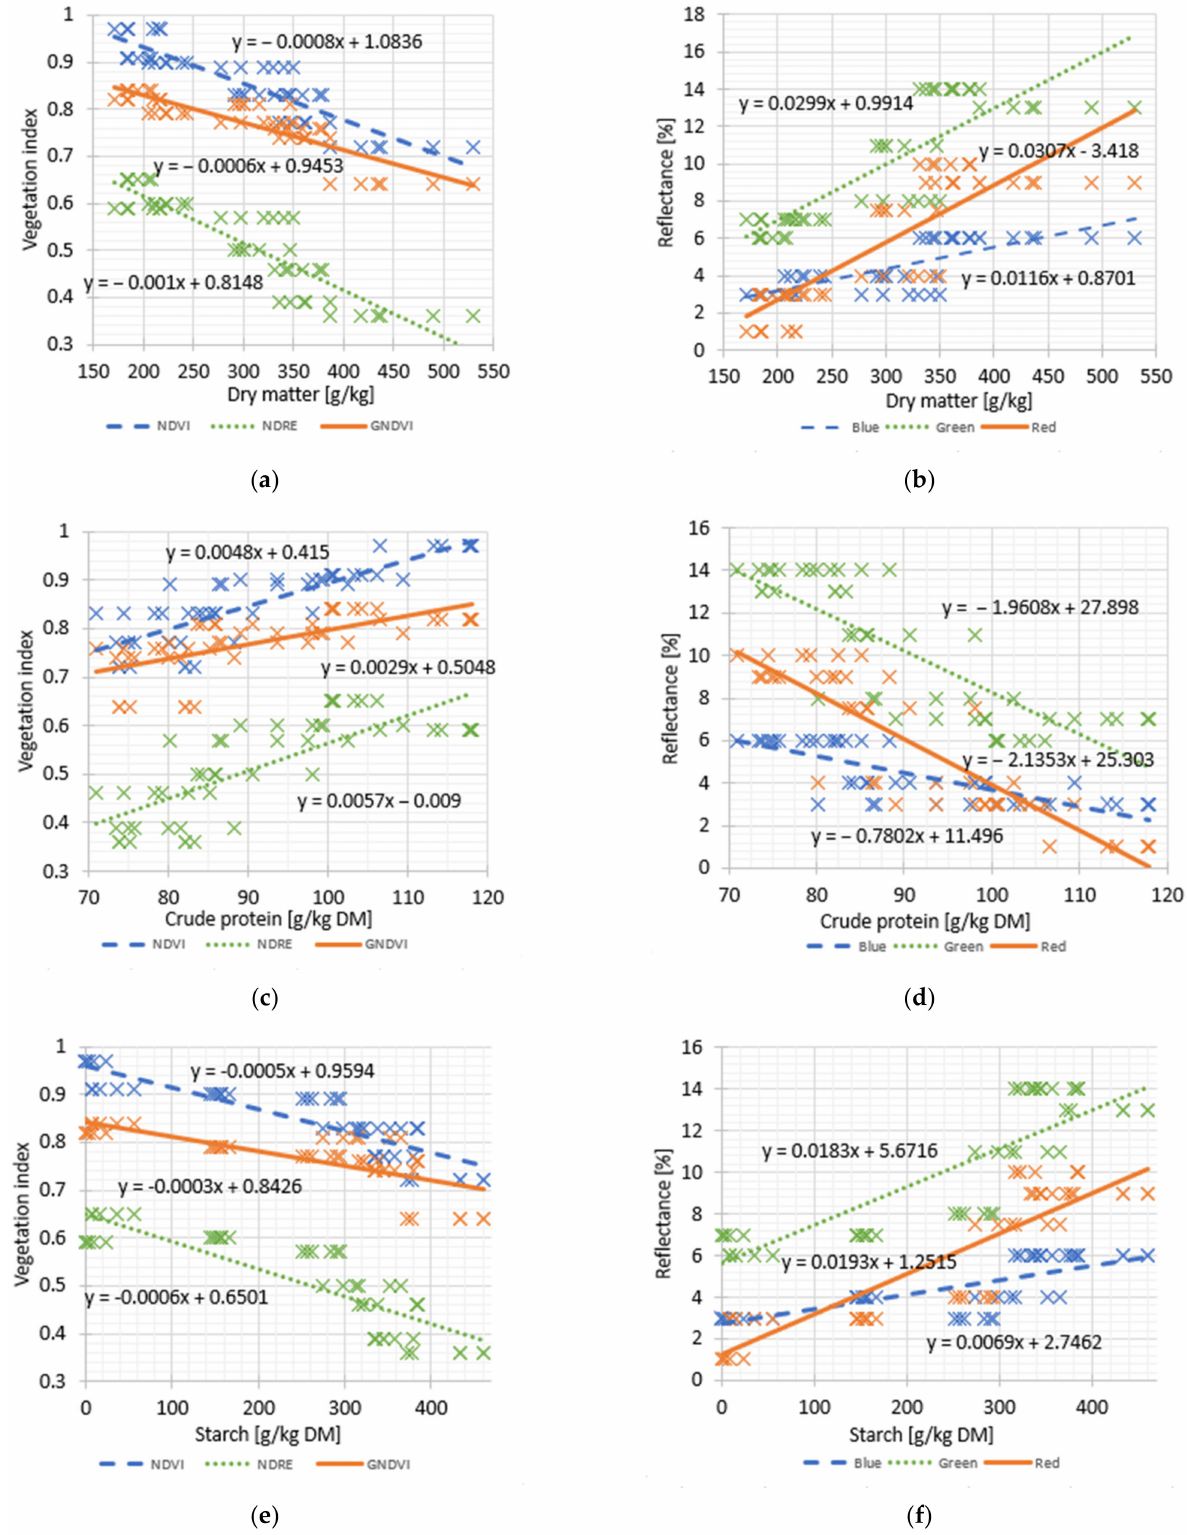
Figure 7. The laboratory-established linear relationships (left) between the vegetation indices (NDVI, NDRE, and GNDVI) (right), and the reflectivity in the red, green, and blue spectral bands, relating: ( a ) the vegetation indices to the dry matter; ( b ) the reflectance to the dry matter; ( c ) the vegetation indices to the crude protein; ( d ) the reflectance to crude protein; ( e ) the vegetation indices to the starch; ( f ) the reflectance to the